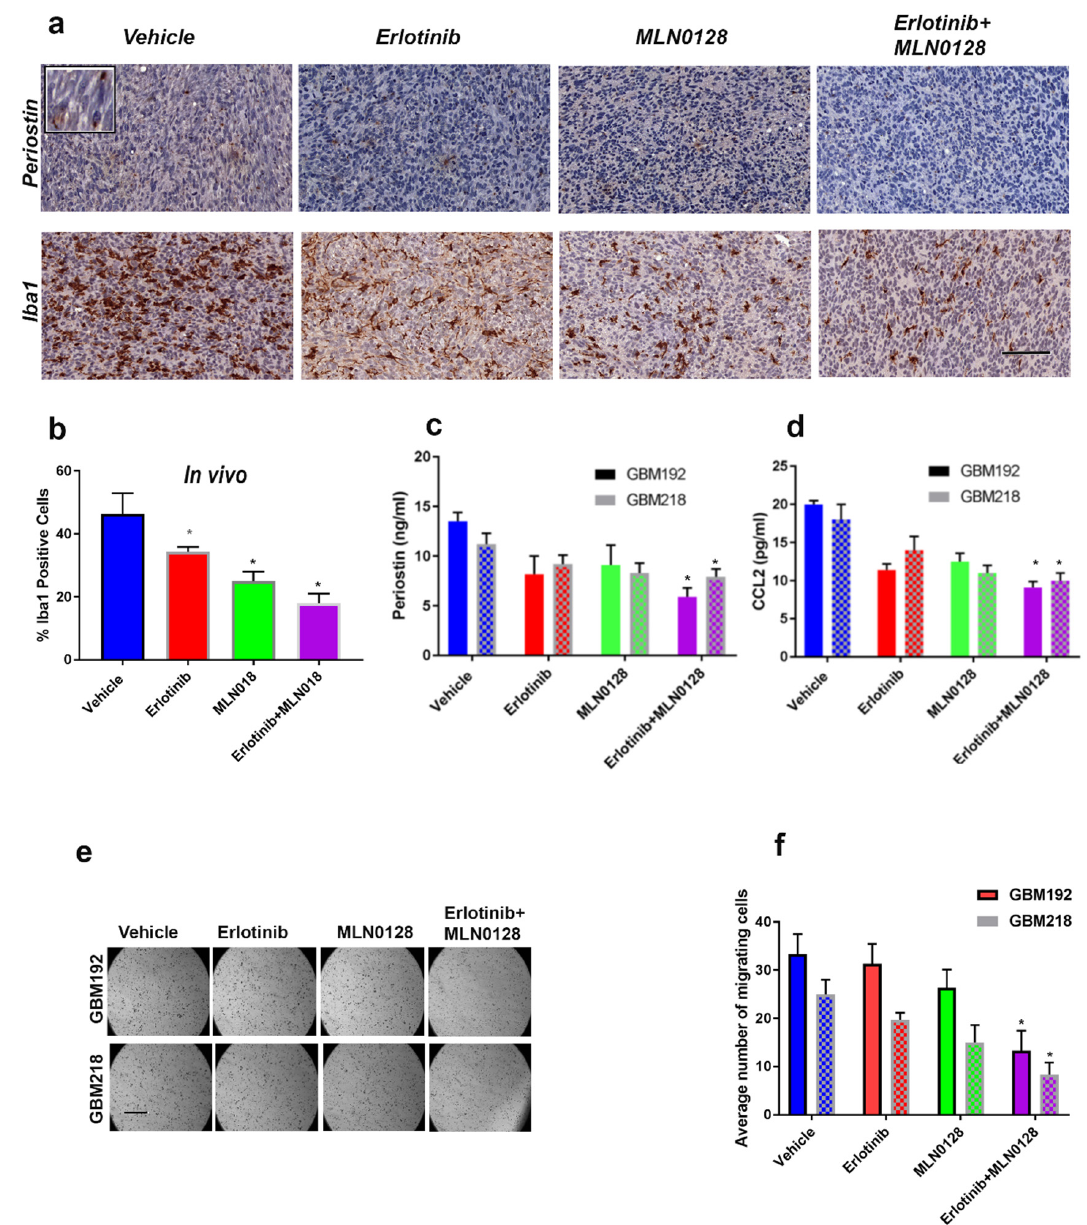
Figure 5. Combinatorial therapy using erlotinib and MLN0128 downregulates POSTN and CCL2 levels and inhibits the Iba1-positive macrophages in the GBM TME. ( a ) POSTN (upper panels) and Iba1 (lower panels) immunohistochemical staining of GBM PDX samples from mice treated as indicated. Representative photomicrographs are shown. Bar = 150 µ m. ( b ) Quantification of Iba1 positive cells in GBM192 treated xenografts was performed by counting 6 low-magnification fields in 2 sections/mouse; 3 mice/treatment group. * p < 0.05 for each treatment compared to vehicle ( t -test). ( c ) ELISA detection of POSTN in GBM192 (solid bars) and GBM218 (patterned bars) cultured over 48 h in the absence of growth factors and treated with inhibitors erlotinib 20 µ M and MLN0128 1 µ M. * p < 0.05 comparing dual therapy to vehicle. The experiment was repeated three times and data from a representative experiment are shown. ( d ) ELISA measurements for CCL2 in supernatant from GBM192 (solid bars) and GBM218 (patterned bars) cultured over 48 h in the absence of growth factors and treated with inhibitors as shown. * p < 0.05 dual therapy compared to vehicle. The experiment was repeated three times and results from a representative experiment are shown. ( e ) Supernatants from GBM192 (upper panels) and GBM218 (lower panels) treated as explained for c–d were used to induce chemotaxis of U937 cells in a transwell migration assay. Representative photo- micrographs are shown. Bar = 250 μ m. ( f ) Quantification of migrating cells shown in e. Four fields were counted per condition and each condition was run in triplicate. The experiment was repeated